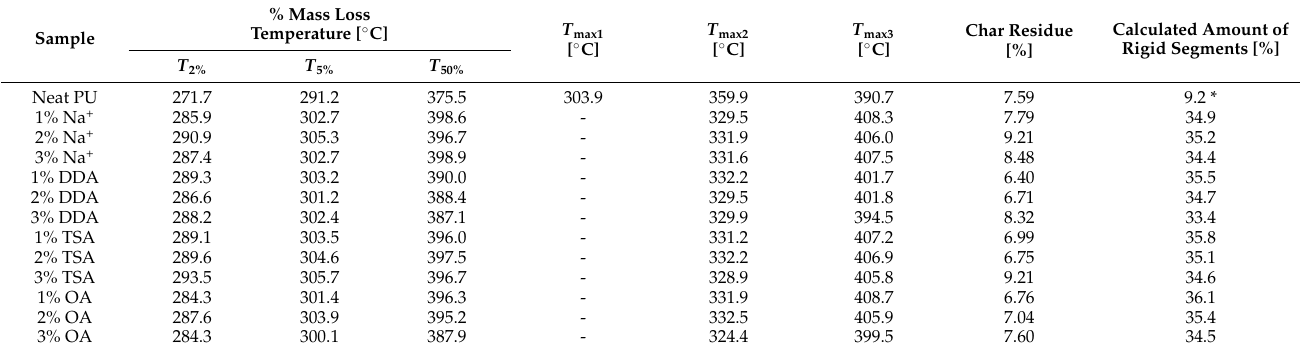
Table 4. Results of thermogravimetric